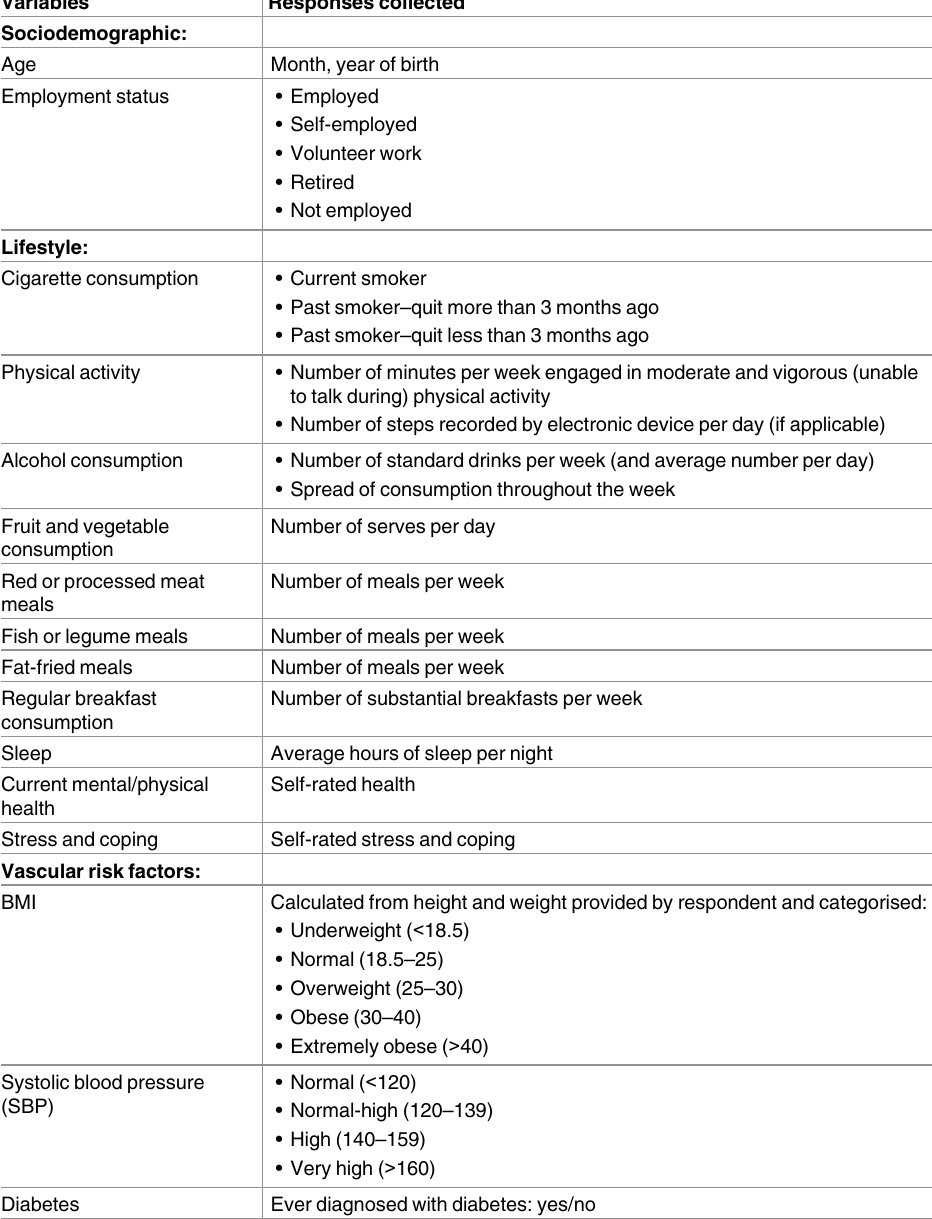
Table 2. Key variables of